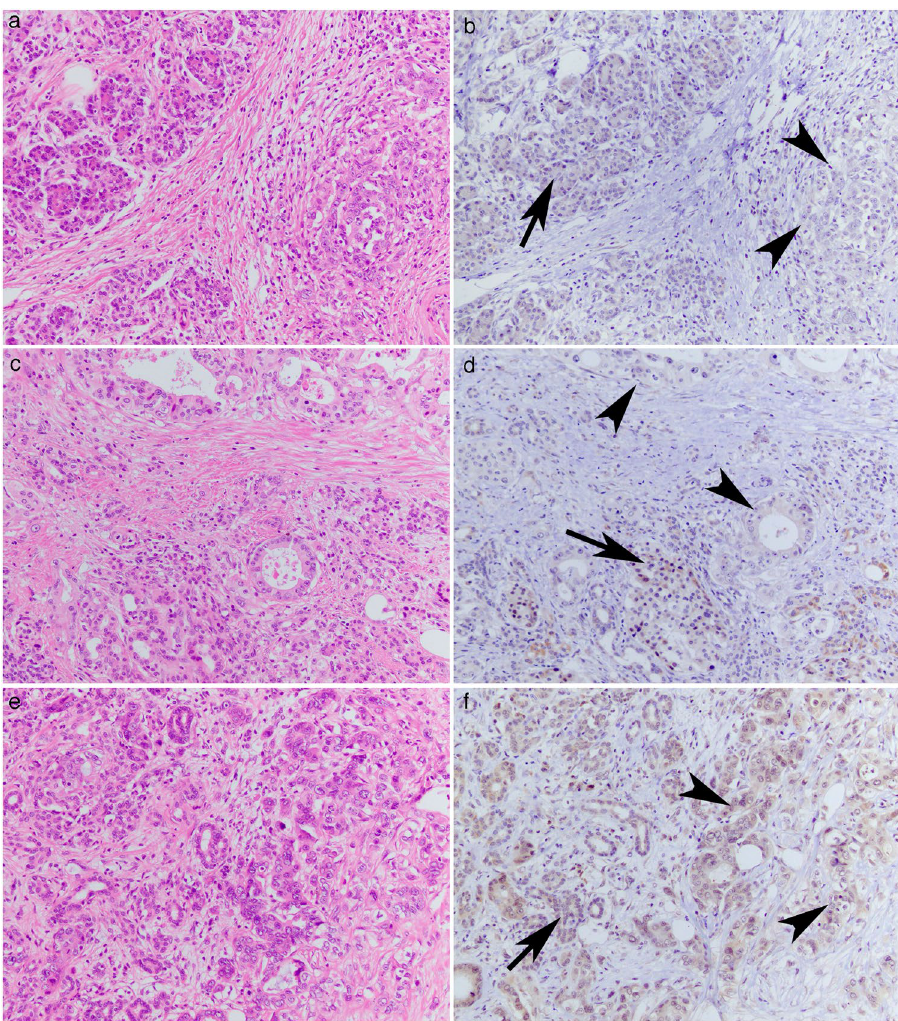
Figure 2. Expression of BRCA2 protein in pancreatic ductal adenocarcinomas. The tissues of Case 17 ( a , b ) and Case 19 ( c , d ) showed reduced expression of BRCA2 in the ductal carcinomas (arrowheads in b and d) in comparison with adjacent normal acinar and islet cells (arrows in b and d ). The tissue of Case 29 ( e , f ), in which the enrichment of a missense mutant allele in the tumor DNA was detected, showed retained expression of BRCA2 in ductal carcinoma (arrowheads in f ) comparable to the normal acini (an arrow in f ). Images were hematoxylin and eosin staining ( a , c and e ) and the indirect immunohistochemical staining with diaminobenzidine as the chromogen ( b , d and f ). Original magnification, ×